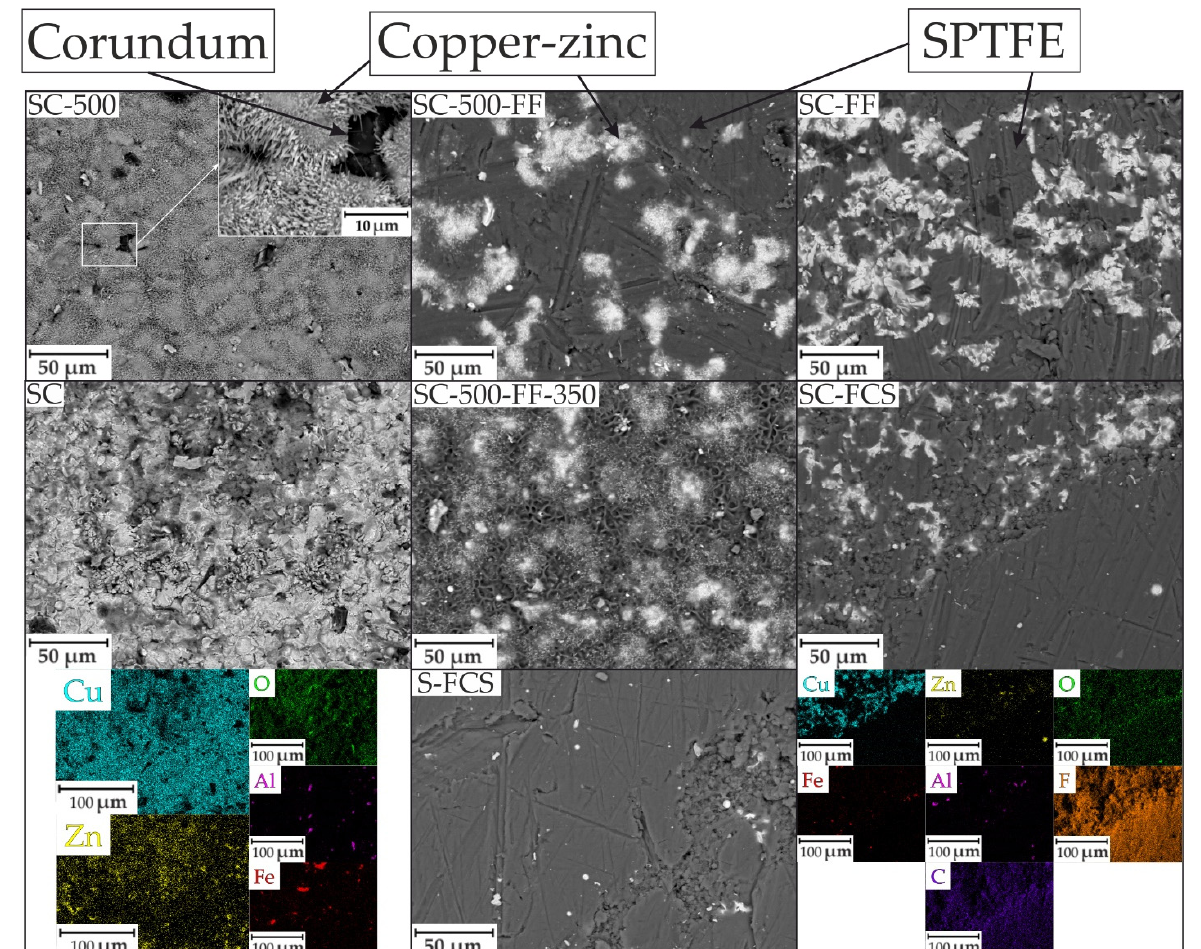
Figure 5. SEM images of the surfaces of coatings formed on St3 steel samples and element distribution maps of SC and SC-FCS samples.